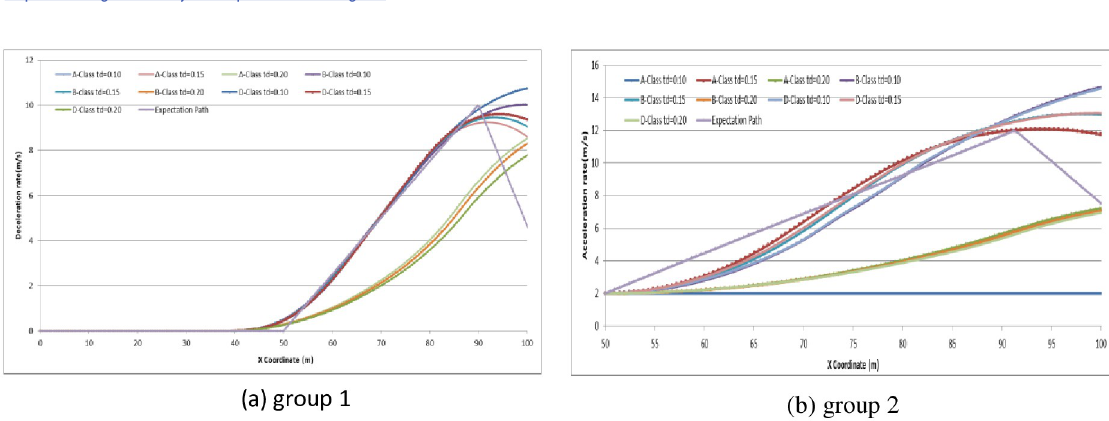
Fig 18. Comparison diagram of operation time delay in different vehicle models at initial speed = 70 km/h.